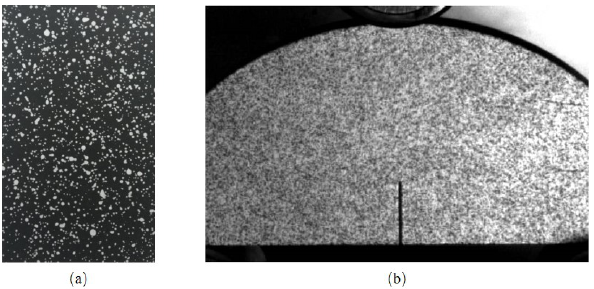
Figure 7. Preparation of artificial speckles by spray painting the surface of the specimen: ( a ) speckle of non-cracked specimen; ( b ) speckle of NSCB specimen.